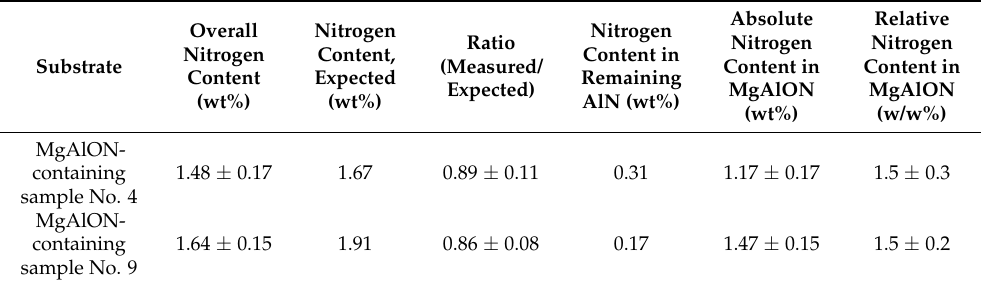
Table 6. Overall nitrogen contents of MgAlON-containing samples No. 4 and No. 9 sintered for 6 h, as determined via carrier gas hot extraction (CGHE), as expected from the initial composition (cf. Tables 3 and 5) and their ratio. The nitrogen contents in the remaining AlN and in MgAlON were calculated from the phase fractions obtained by XRD and from the overall nitrogen content. The absolute nitrogen content in MgAlON is related to the entire sample weight, including remnants of Al 2 O 3 and MgO, whereas the relative content represents the weight fraction of nitrogen within the MgAlON